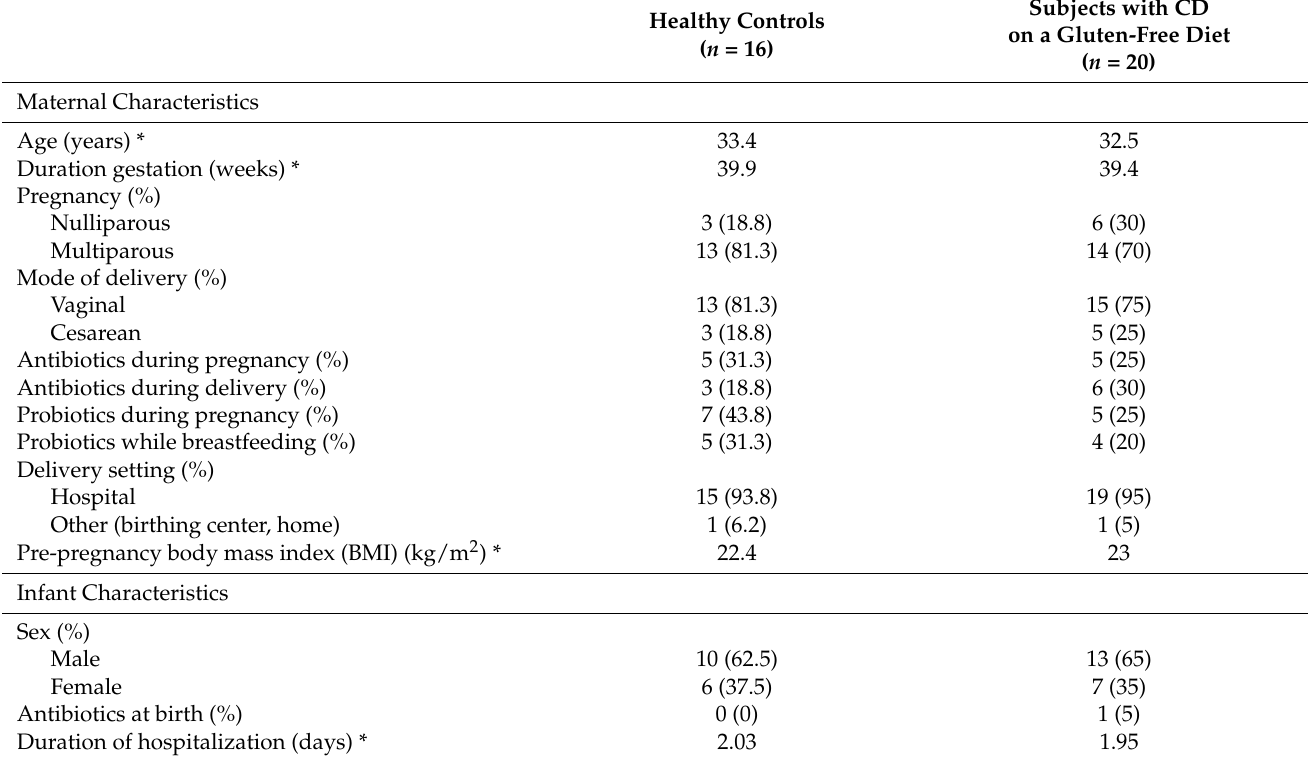
Table 1. Study cohort